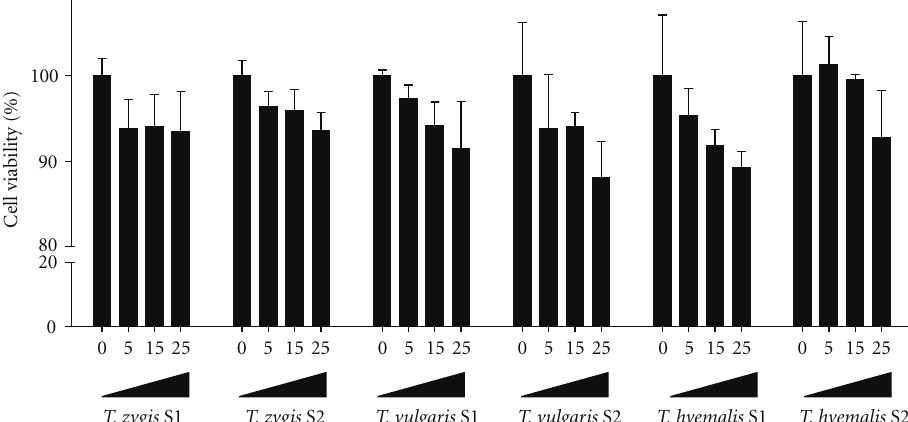
Figure 2: E ff ects of thyme extracts from three di ff erent species ( Thymus vulgaris, Thymus zygis, and Thymus hyemalis ), on macrophage- THP-1 cell viability. Cells were treated with increasing concentrations of thyme extracts, from 0 to 25 μ g/mL for 24h. Cell viability was determined by the MTT assay. Values represent the mean ± SEM of six independent experiments. No statistic signification in P values lower than 0.05 was